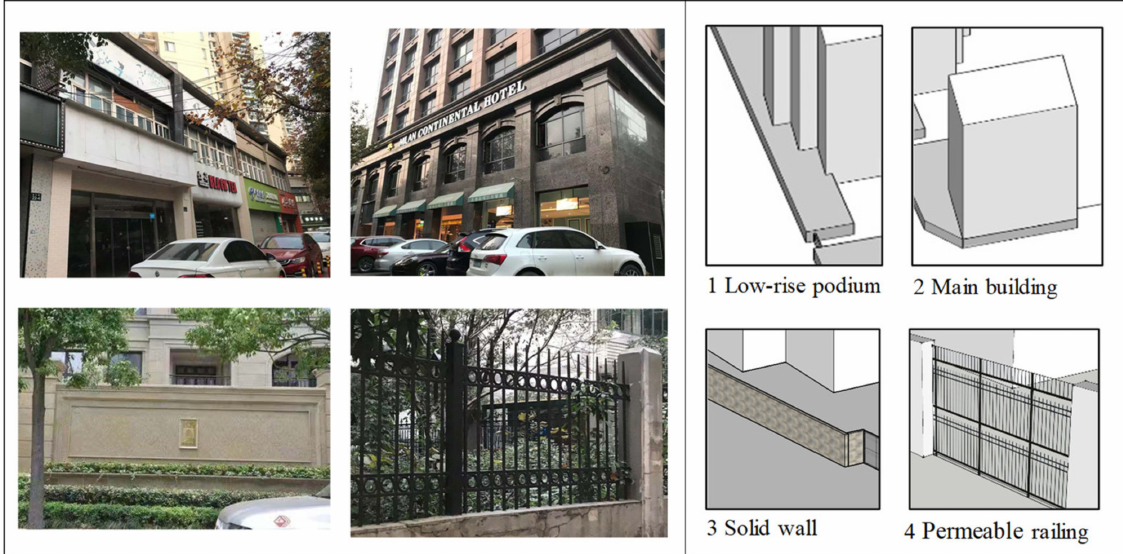
Figure 4. Characteristics of high-density residential districts in the Yangtze River Delta region of China.